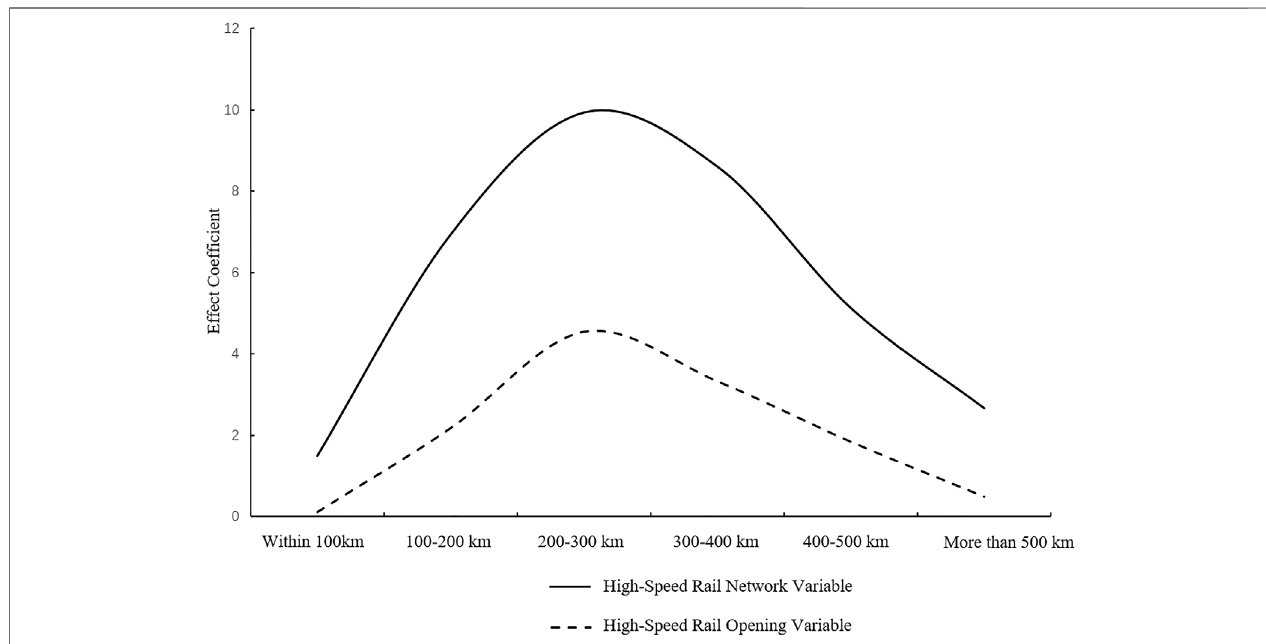
FIGURE 6 | Comparison of regression coef fi cients of cities with different distances.